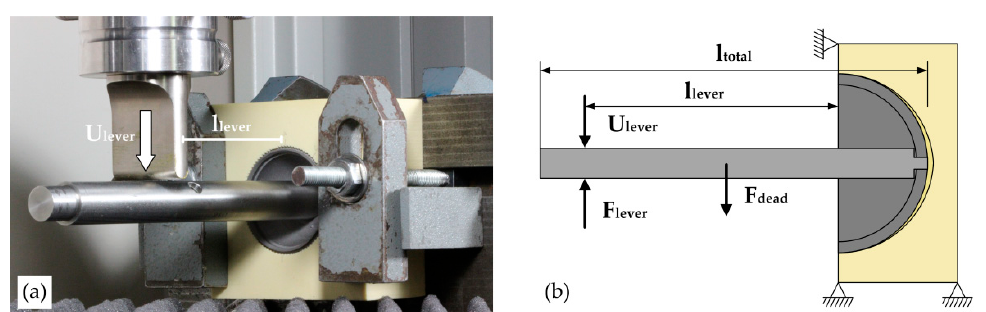
Figure 2. Test method 1—Displacement-controlled lever-out test. ( a ) Experimental test setup for the lever-out test. ( b ) A schematic view of the lever-out test. The parameters required calculating the lever-out moment—the effective lever arm length (l lever ), the applied displacement (U lever ), and the measured ultimate lever-out force (F lever ) have been shown. The intrinsic moment resulting from the parameters—the deadweight of the lever shaft (F dead ) and the total length of the lever shaft (l total )—were also taken into account (Formula (1)).